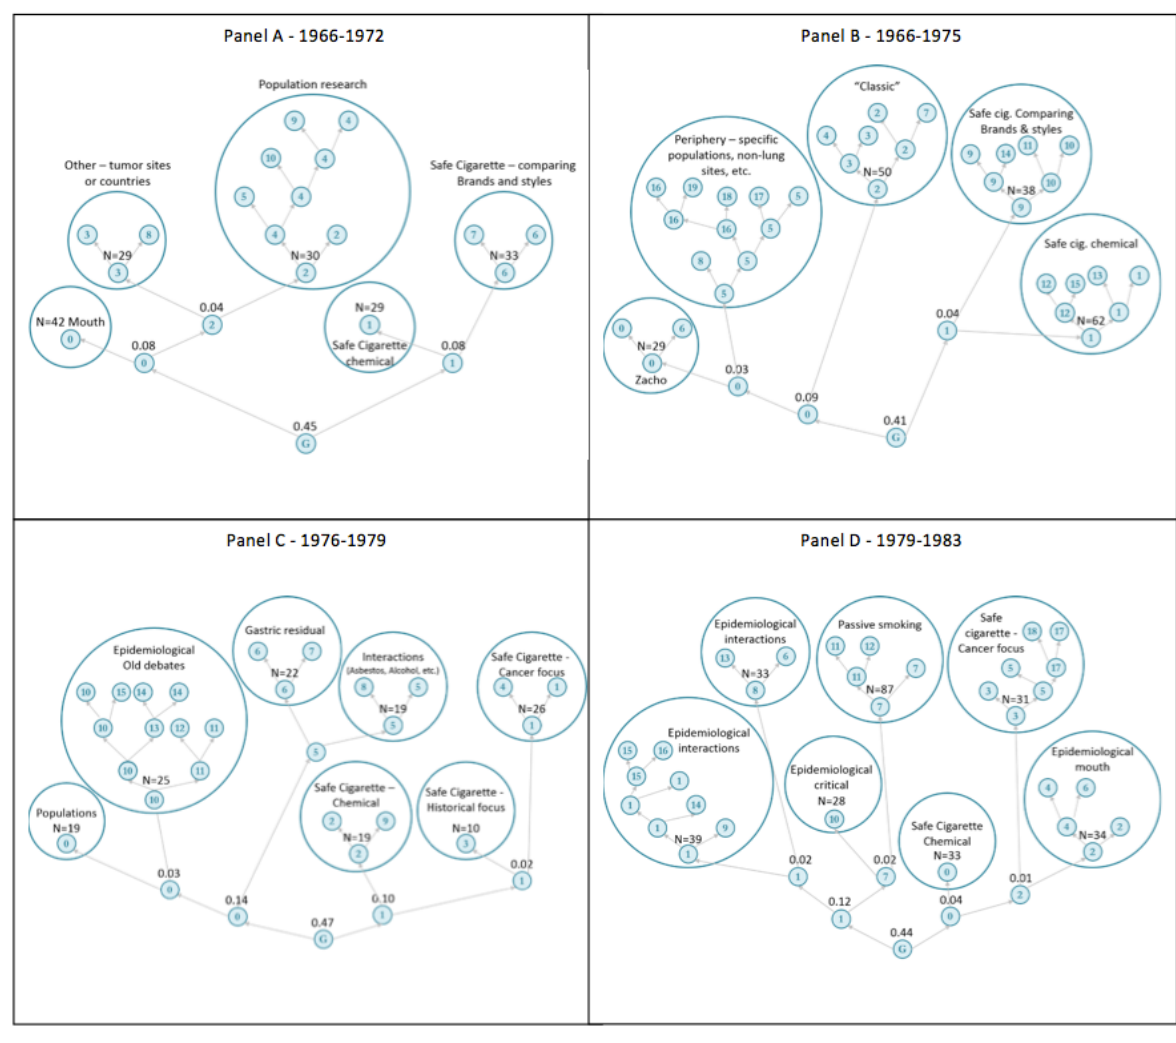
Figure 3: Communities in the 1970s. Community numbers are arbitrary. Decimal fractions refer to the division’s contribution to overall modularity, and N refers to the number of scientific articles in every final community-indivisible or where further divisions’ modularity contribution is less than 0.01. Throughout the 1970s, the primary division clearly distinguishes the camp engaged with developing a safer cigarette from the rest. This logic of division disappears in panel D, two years after the first publication of passive smoking epidemiological evidence.